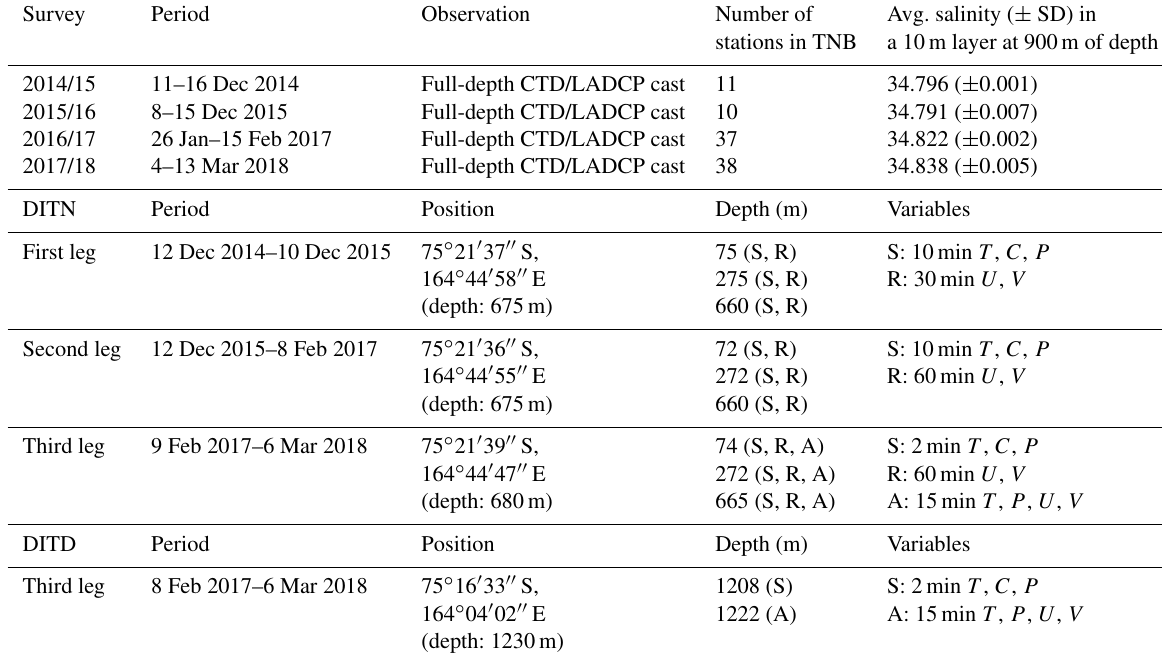
Table 1. Information from the four oceanographic surveys and data from the DITN and DITD. U , V , T , C , and P represent the east–west current speed, north–south current speed, temperature, conductivity, and pressure, respectively. S, R, and A are the instrument abbreviations for the SBE37SM, RCM9, and Aquadopp current meters,